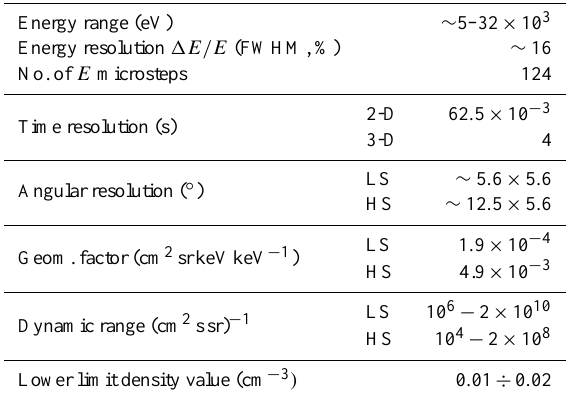
Table 1. The HIA specific parameters according to Rème et al. (2001) and Dandouras and Barthe